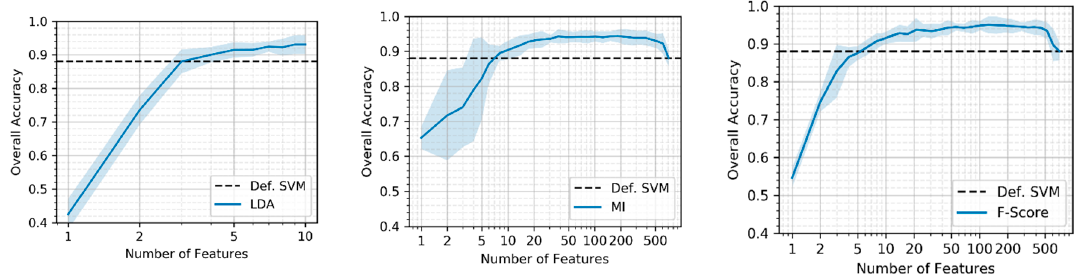
Figure 6. Overall accuracy as function of the number of features used (Stockholm).